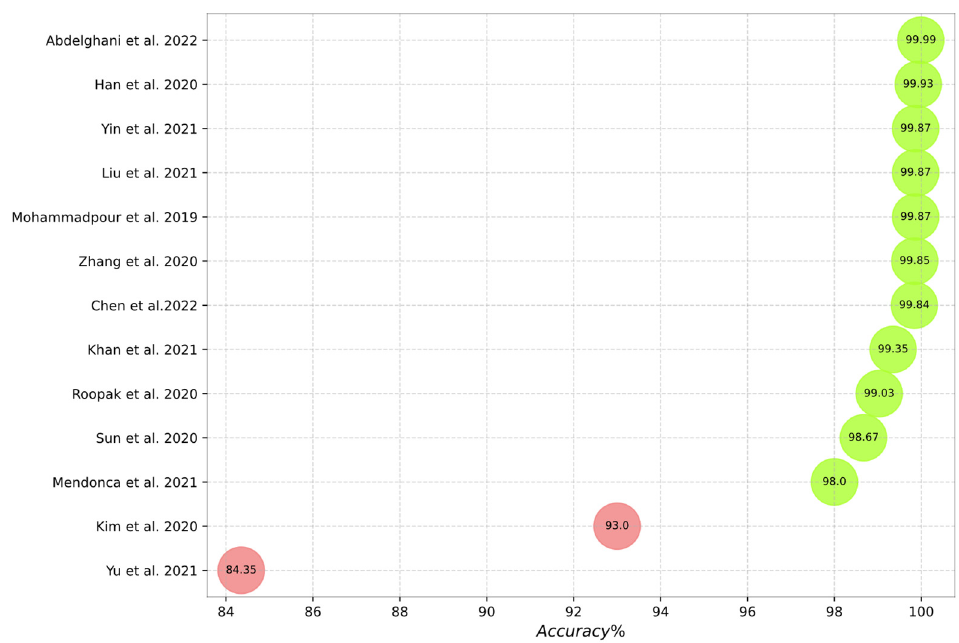
Figure 12. Accuracy of the studied schemes on the CIC-IDS 2017 dataset [15,18,41,44–46,48,52,66,68,71,73,76].